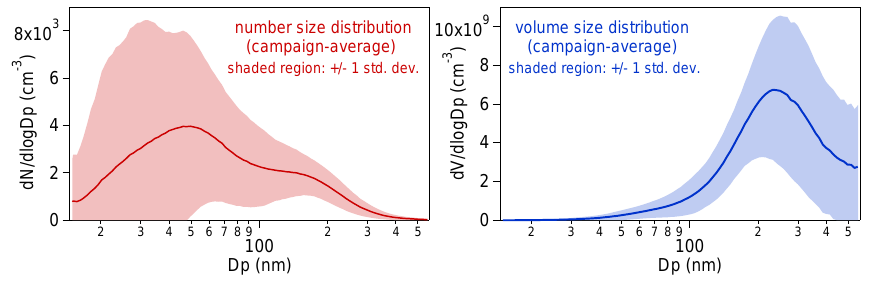
Fig. 4. Campaign-average number (left) and volume (right) size distributions for FAME-09. The particle size distributions were more variable and the particles were smaller on average during FAME-09 than during FAME-08.